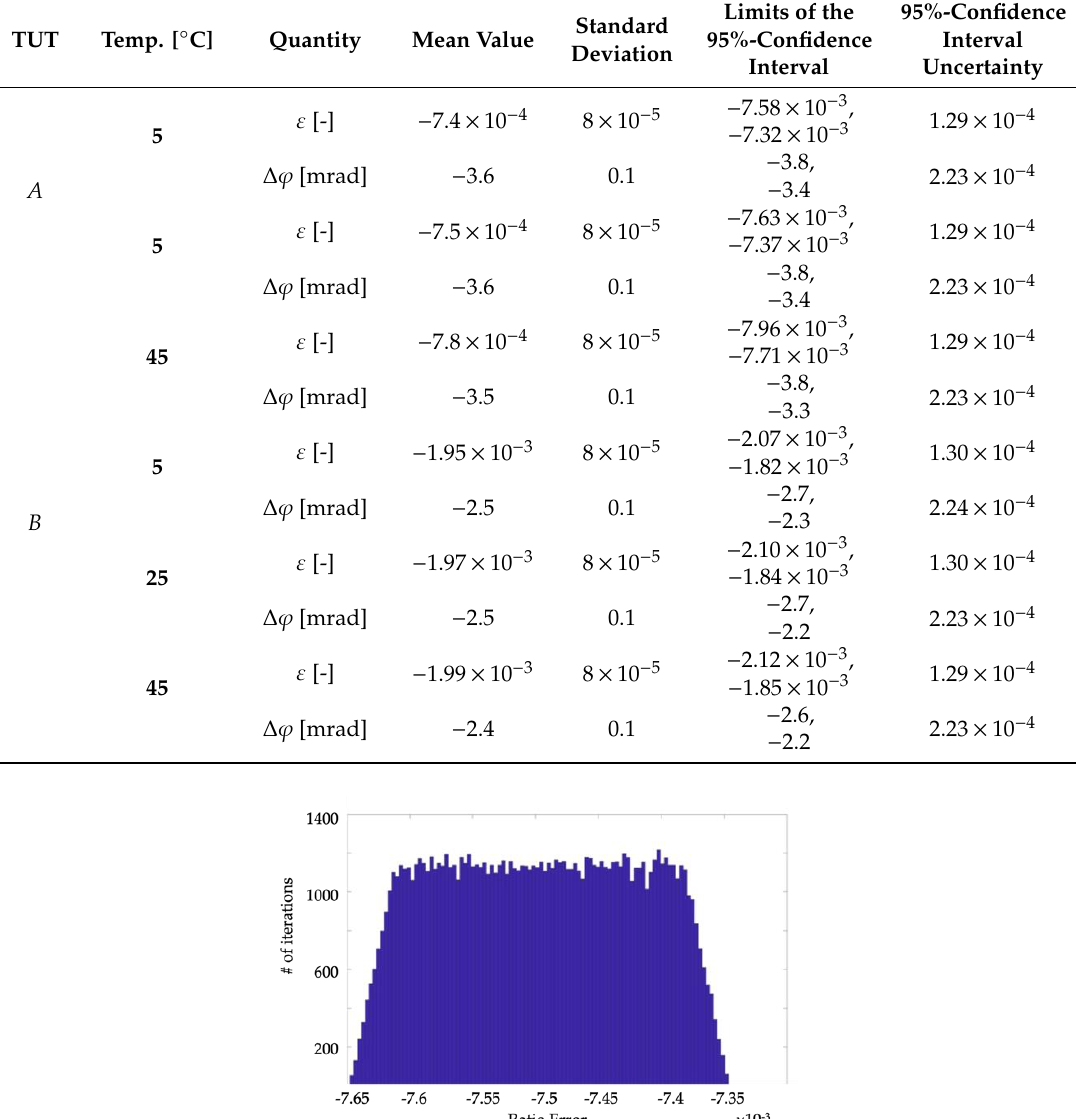
Table 6. Results of the MC method application when considering the metrological characterization of the items for the uncertainty evaluation.